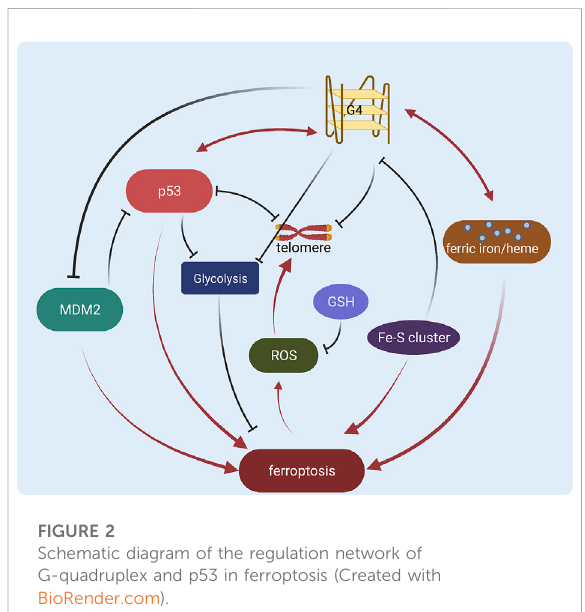
FIGURE 2 Schematic diagram of the regulation network of G-quadruplex and p53 in ferroptosis (Created with